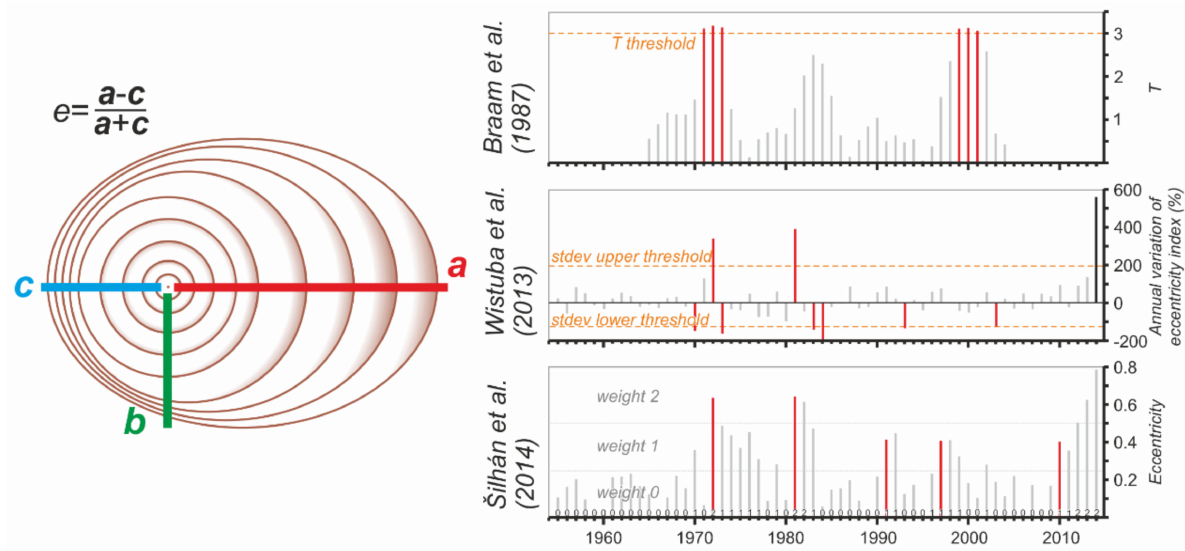
Figure 4. The scheme of tree-ring eccentricity including three types basic approaches of signal detection from rows of tree-ring